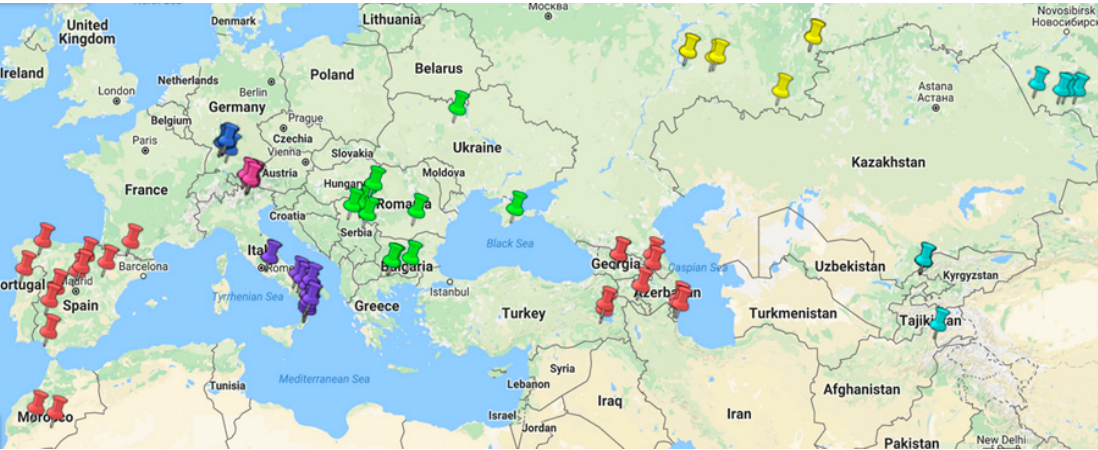
Figure 2. The distribution of the plants across different regions.